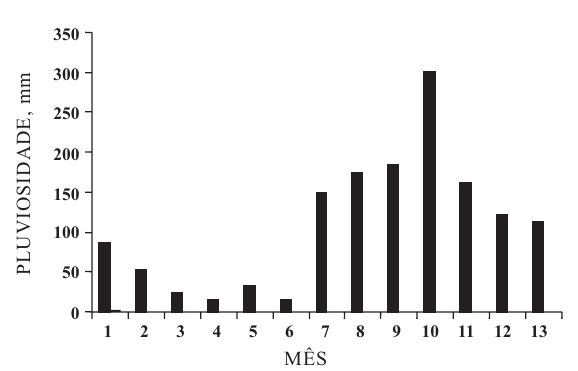
Figura1. Pluviosidade da área experimental no período de abril de 2003 (1) - abril de 2004